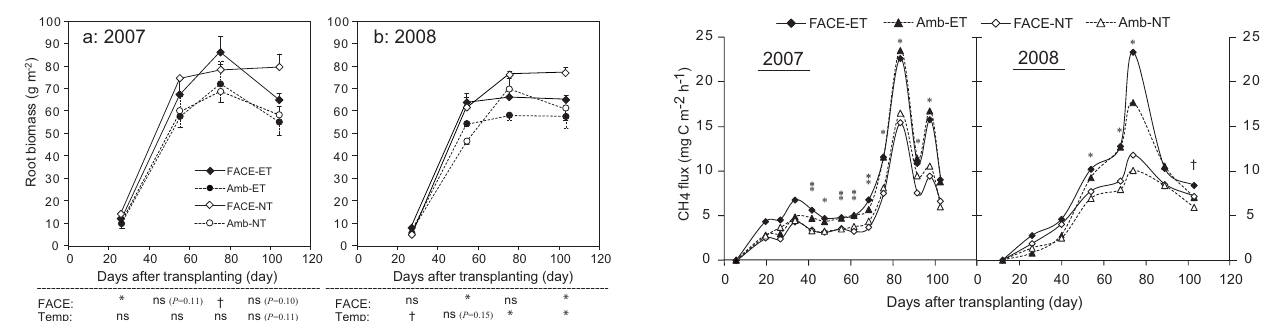
Fig.1. Timecourseofrootbiomassin2007 (a) and2008 (b) . Rootsweresampledoutsidethemini-plotswhere Fig. 1. Time course of root biomass in 2007 (a) and 2008 (b) . Roots theCH 4 fluxwasmeasured. Barsindicatestandarderrors( n = 3). Symbolsindicatethelevelofsignificanceof were sampled outside the mini-plots where the CH 4 flux was mea- elevated temperature: n.s., not significant; †, P < 0 . 1; *, P < 0 . 05. sured. Bars indicate standard errors ( n =3). Symbols indicate the level of significance of elevated temperature: n.s., not significant; †, P < 0.1; *, P < 0.05.